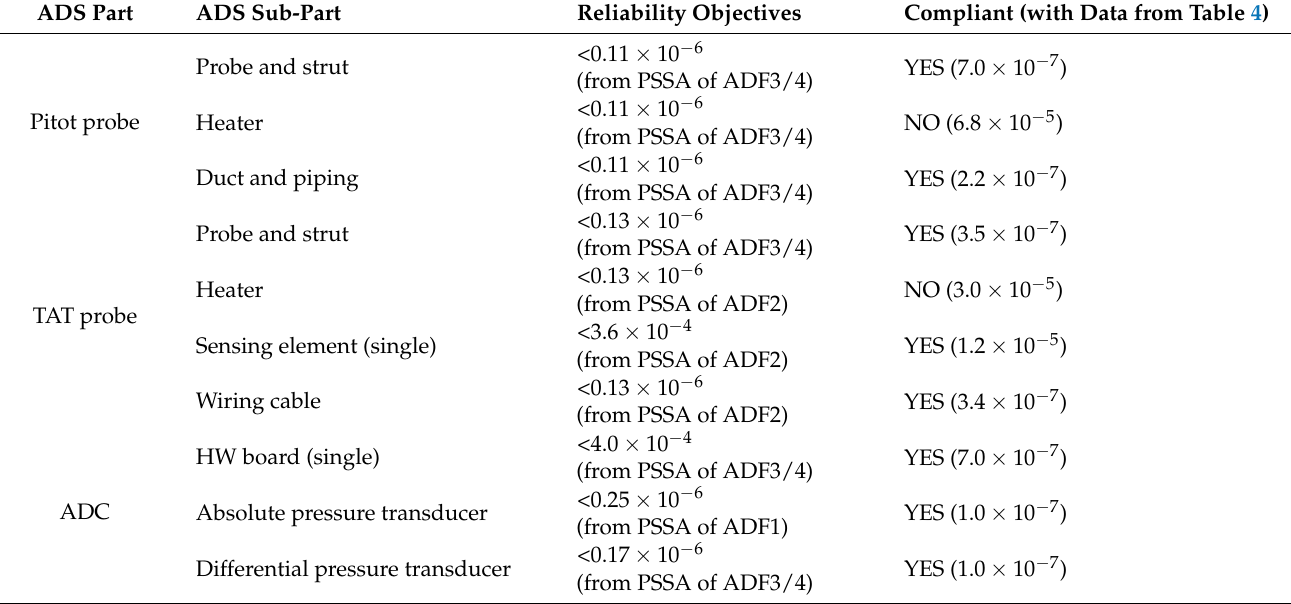
Table 6. Failure probability requirement for the ADS components for erroneous failure conditions. The present requirements are the most severe from those obtained with Fault Tree Analysis (FTA) presented in Figure 4. ADS